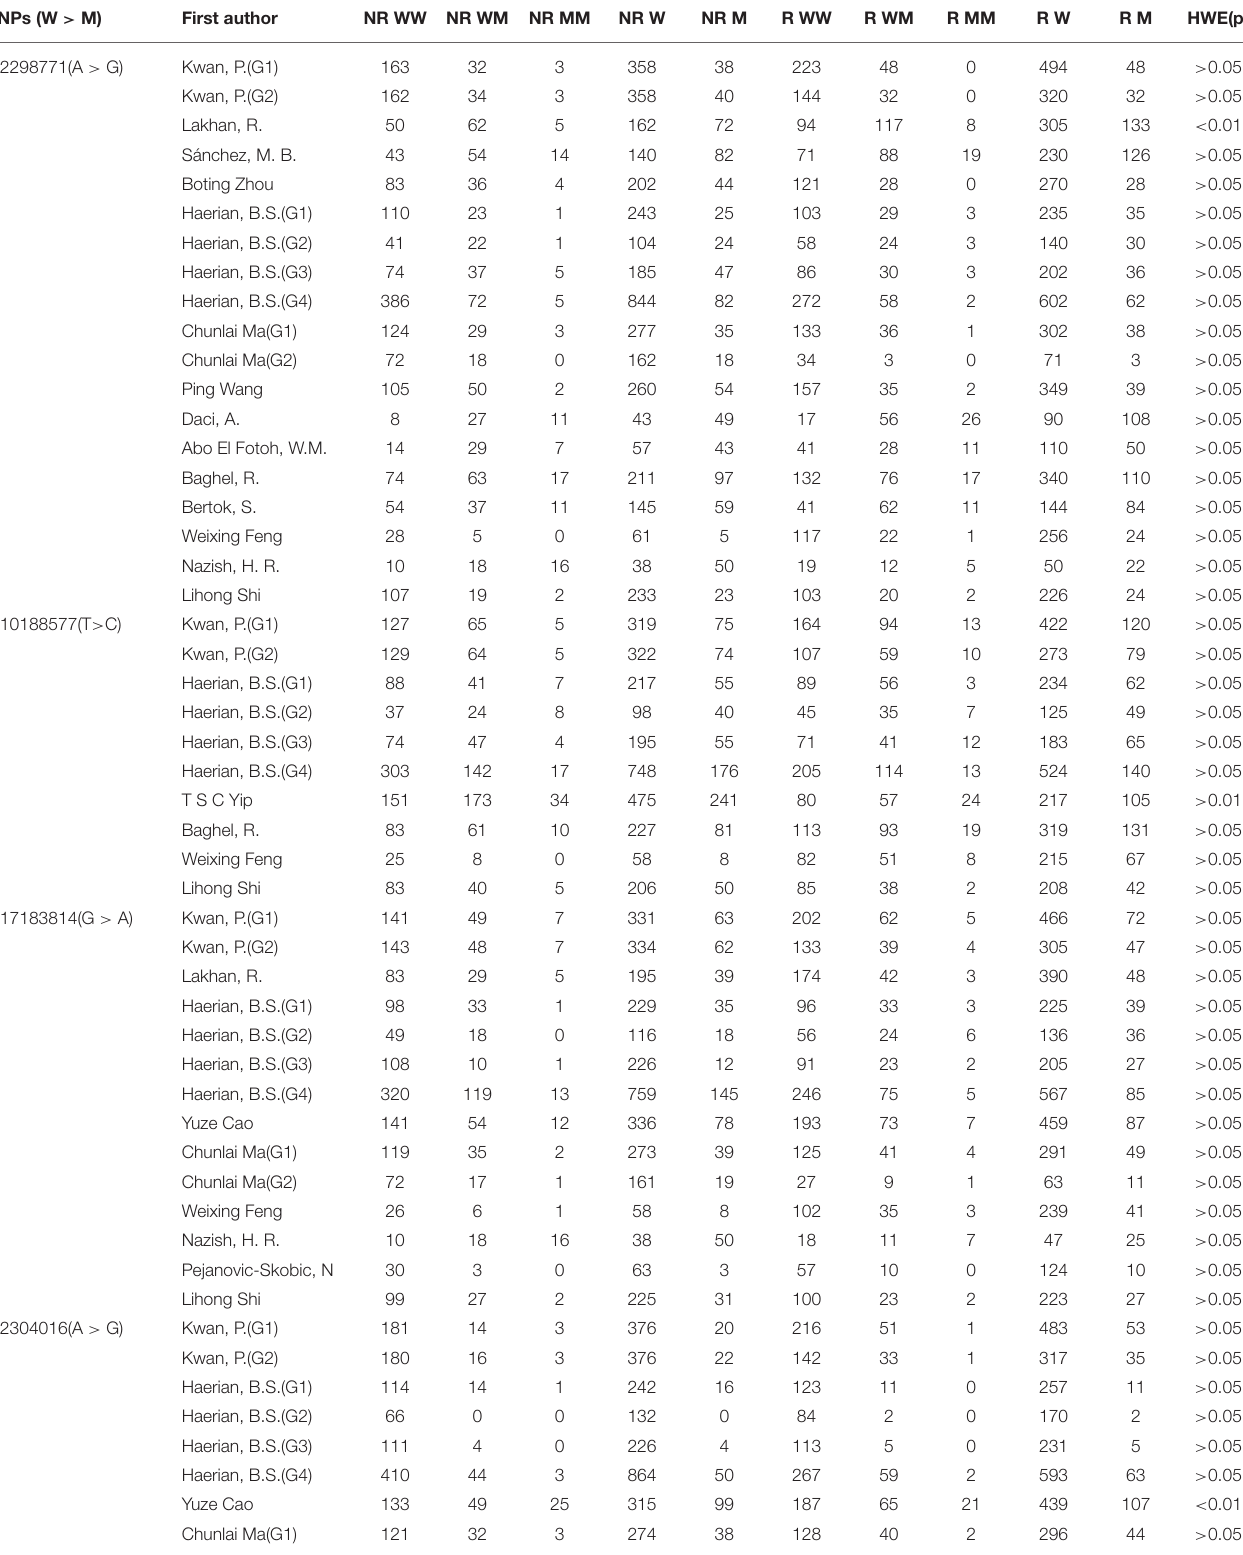
TABLE 2 | Genotype and allele distributions of SCN1A and SCN2A gene loci. SNPs (W >